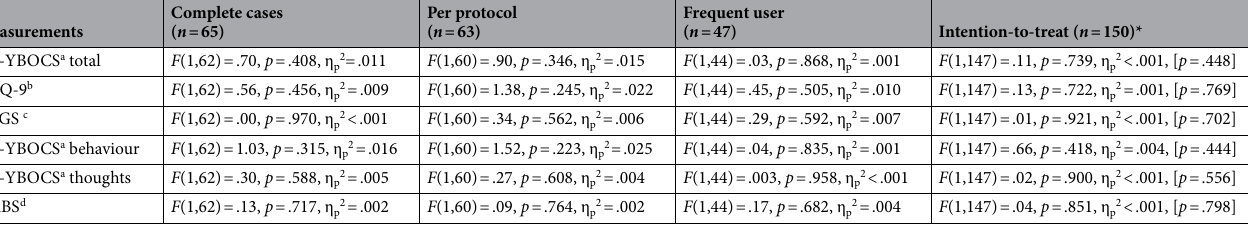
Table 3. Between-group difference pre-post; ANCOVAs with baseline scores as covariates. * Intention-to- treat analyses were computed with expectation maximization as the method for replacing missing values. The square brackets contain the p -value of analyses with multiple imputation as the method for replacing missing values. a Pathological Gambling Adaptation of Yale-Brown Obsessive Compulsive Scale. b PHQ-9: Patient Health Questionnaire–9. c South Oaks Gambling Screen. d Gambling Attitudes and Beliefs Survey.